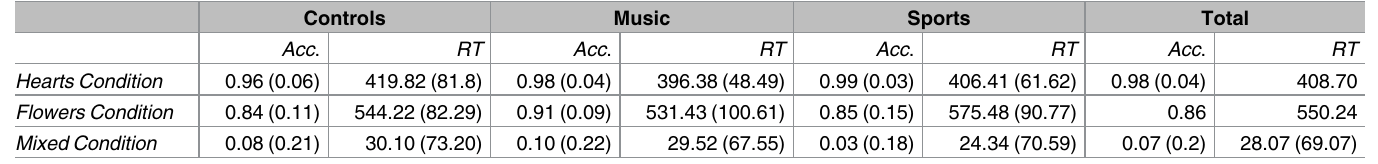
Table 3. Mean accuracyand response time during the three conditions of the Heartsand Flowers task.